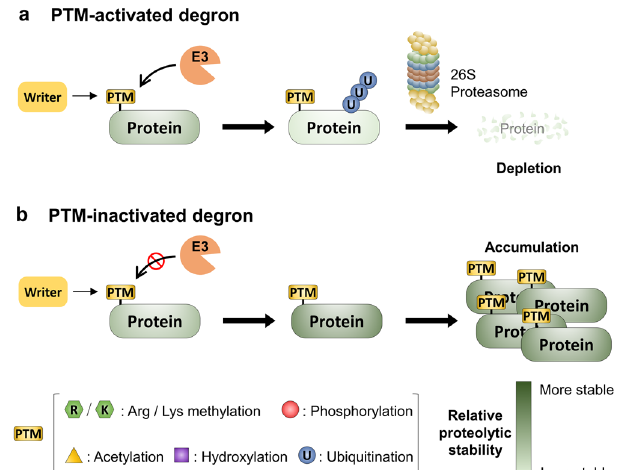
Fig. 1 | Examples of two opposite archetypal regulatory modules: the PTM- activated degron and PTM-inactivated degron. a PTM-activated degron: Writer enzymes generate PTMs at speci fi c residues within target proteins that are recog- nized by an E3 ubiquitin ligase complex for proteasome degradation. PTM- activated degron is a natively inactive degron structure, modi fi ed, or otherwise activatedbytheadditionofoneormorePTMs,ultimatelyleadingtotheproteolytic degradation of a protein. b PTM-inactivated degron: PTMs added to speci fi c sites on protein substrates to inhibit their interaction with the protein degradation machinery. PTM-inactivated degron is a destabilization motif thatisinactivated by the addition of one or more